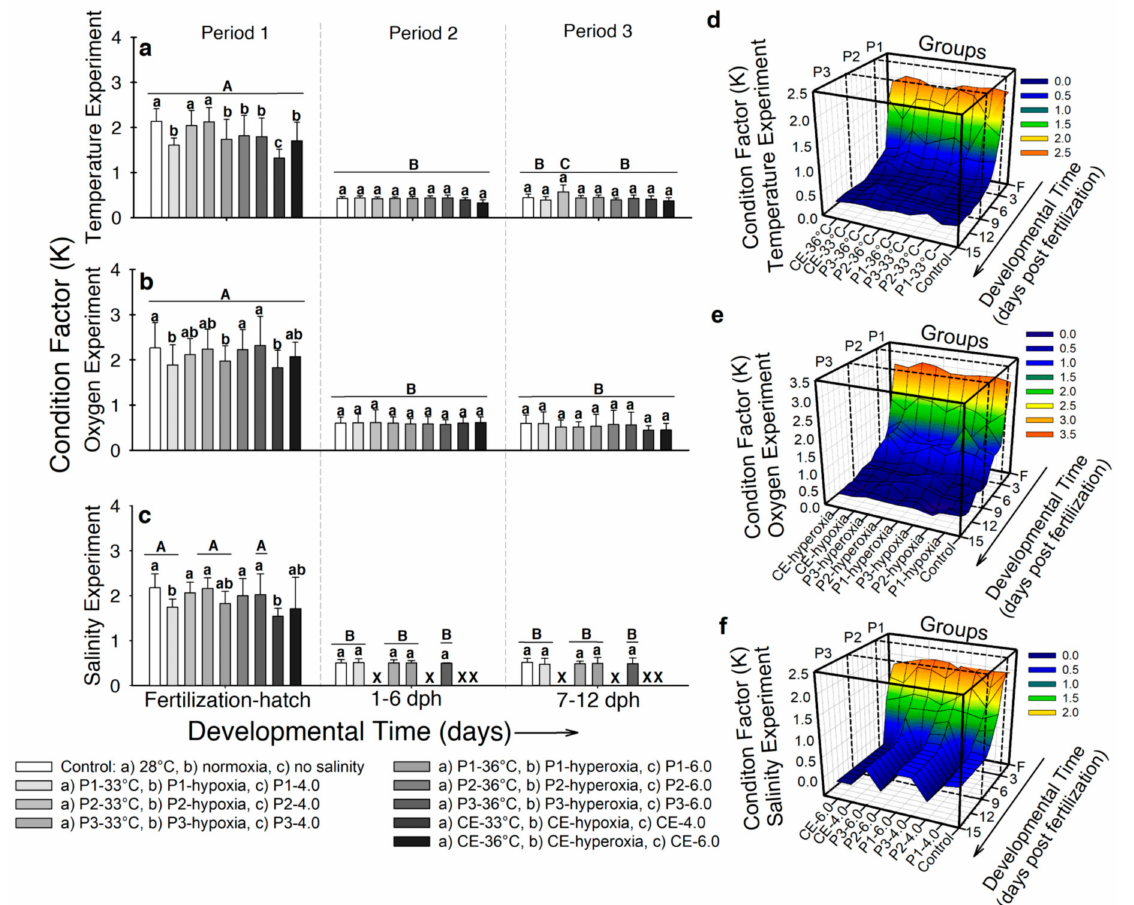
Figure 5. Fulton’s condition factor (K) of Atractosteus tropicus at the end of each developmental period. ( a ) Temperature, ( b ) air saturation, and ( c ) salinity experiments. Means ± SEM are presented. Lowercase letters represent differences between experimental groups from each developmental period ( p < 0.001). Capital letters indicate differences within developmental time for each experimental group ( p < 0.001). Panels ( d – f ) show the relation between development, treatments, and effect on condition factor of the fish in the whole experiments for temperature, air saturation, and salinity, respectively. Control conditions: 28 ◦ C, 0.0 ppt of salinity, normoxia (95% air saturation); treatments 1: 33 ◦ C, hypoxia (~30% air saturation), or 4.0 ppt of salinity respectively to each experiment; treatments 2 (independently for each experiment): 36 ◦ C, hyperoxia (117% air saturation), or 6.0 ppt of salinity respectively to each experiment. Black crosses (X) in the salinity experiment represent groups where all fish died. n = 20 for each